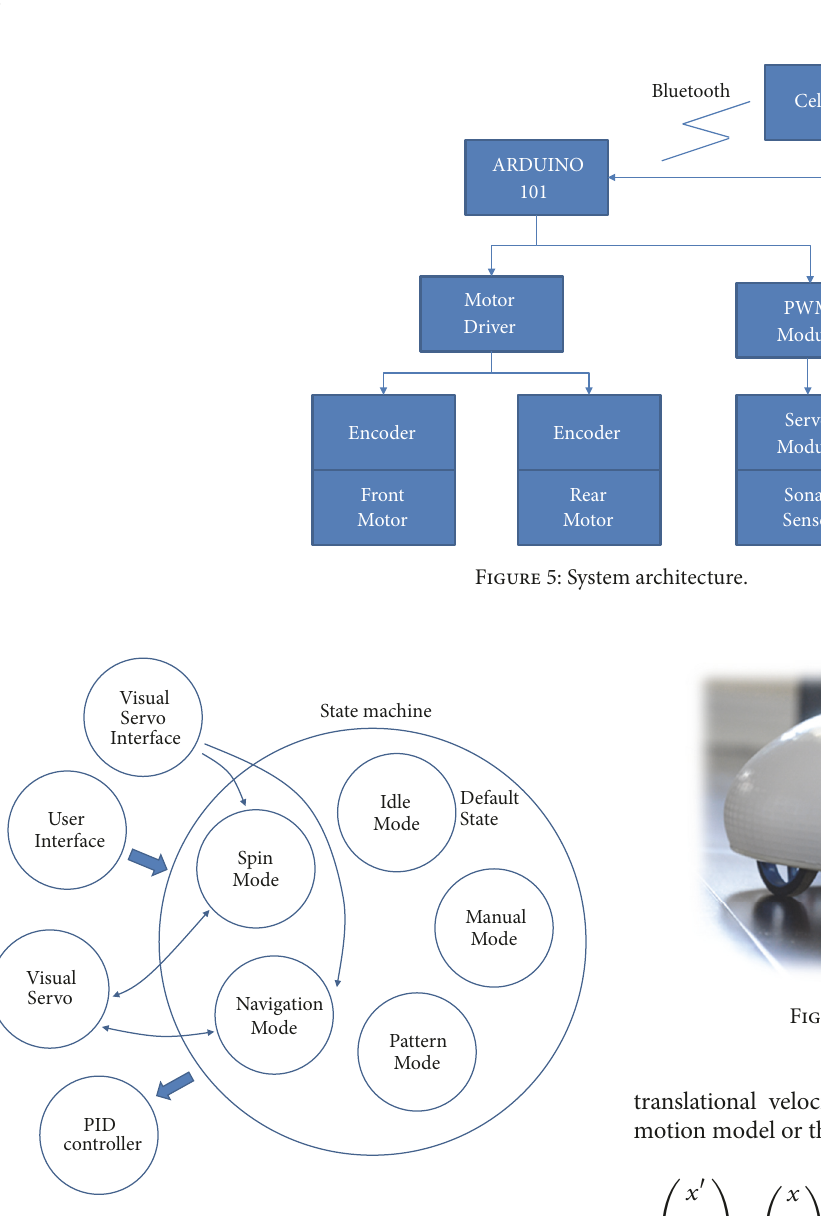
Figure 6: Software architecture.